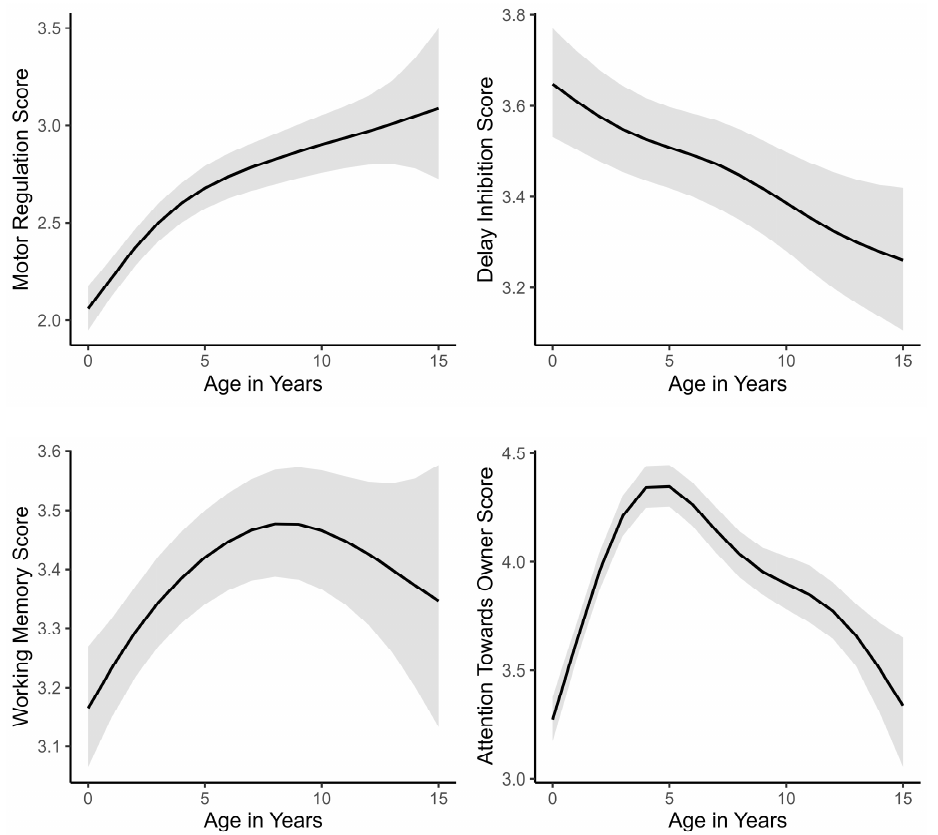
Figure 1. Estimated smoothing curves of the relationship of subscale scores for Motor Regulation, Delay Inhibition, Working Memory and Attention Towards Owner and dogs’ age in years. Solid lines are the smoothers and shaded regions indicate 95% confidence intervals.